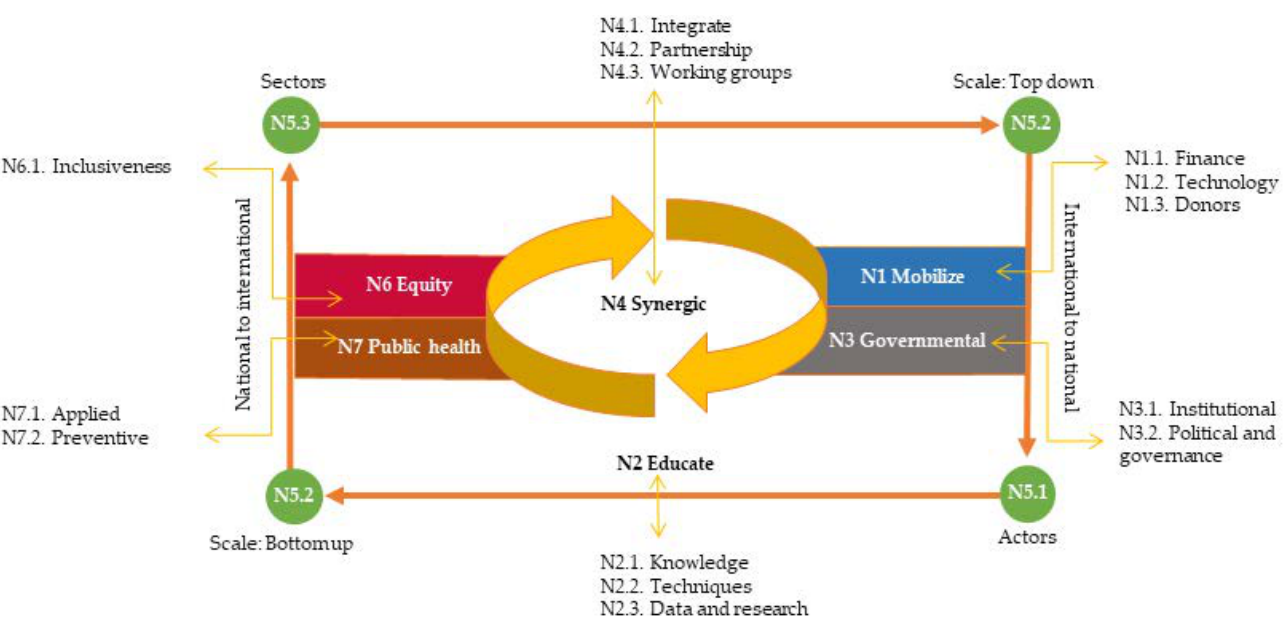
Figure 2. CAN model: overview of need categories, their relationships, and